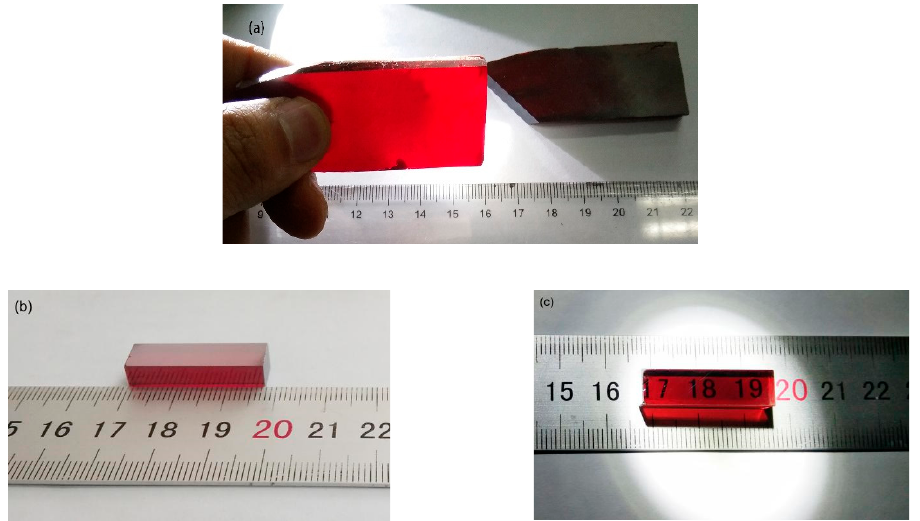
Figure 3. The prepared AGGSe crystal ( a ) slices, ( b ) sample and ( c ) sample under table lamp light with 6 mm thick.